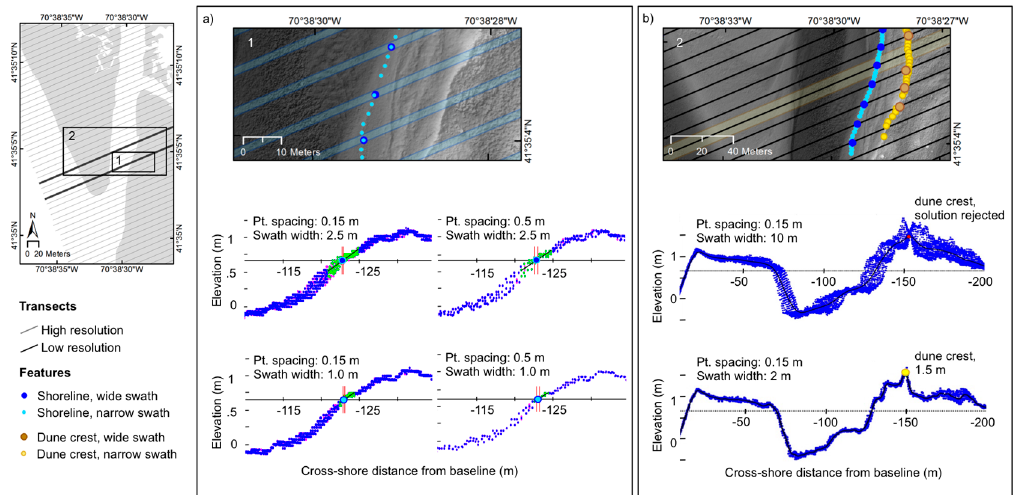
Figure 4. Examples of feature extraction using cross-shore elevation profiles. ( a ) Shoreline extraction at the transect represented by the blue swath in the center of the map (Inset 1). Shoreline positions are represented in the map and the cross-shore elevation plots as blue points; dark blue points were positioned from the wide swaths and light blue points were positioned from the narrow swaths. Green points represent the foreshore region with a black line representing a linear regression fit through those points; red vertical lines indicate the 95% confidence interval of the solution. The four plots show profiles extracted in 2-m and 1-m alongshore swaths from the 15-cm and 50-cm spaced point cloud (as indicated). ( b ) Dune feature extraction at the transect represented by the yellow band in the map (Inset 2) from 15-cm spaced point clouds and at two swath widths, as indicated. A yellow point represents a dune crest that was extracted successfully; a red point represents a solution rejected by the operator. Dune toe position could not be computed in either profile and dune crest position was only identified with the 2-m swath.